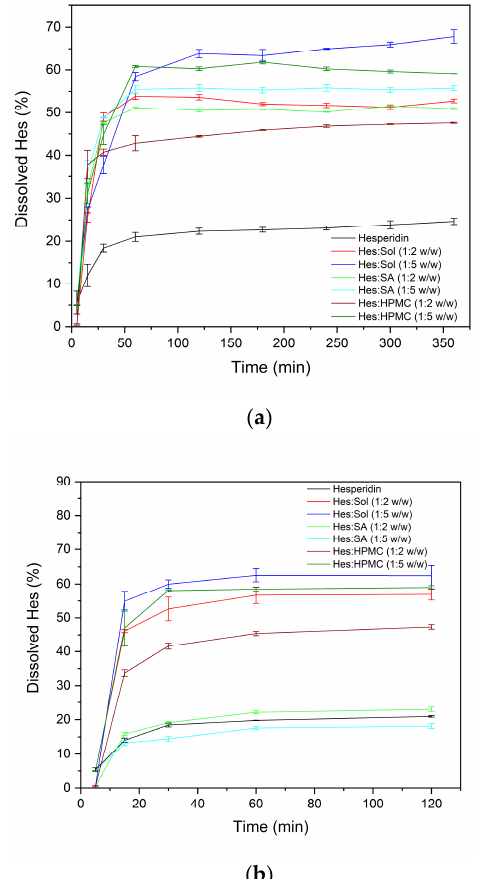
The obtained amorphous systems impacted the dissolution profile of Hes in phosphate buffer and HCl (Figures 7a and 7b respectively).